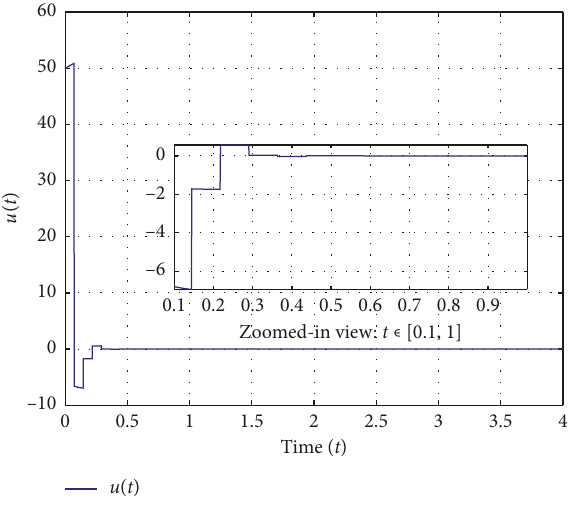
Figure 6: Fuzzy sampled-data control input u ( t ) .